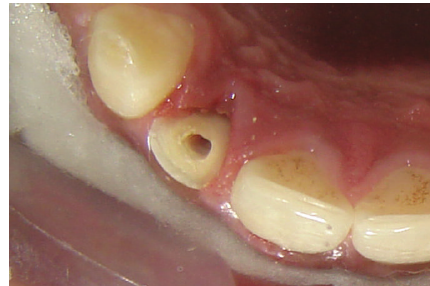
Figure 3: Fractured fragment stored in distilled water till further use.